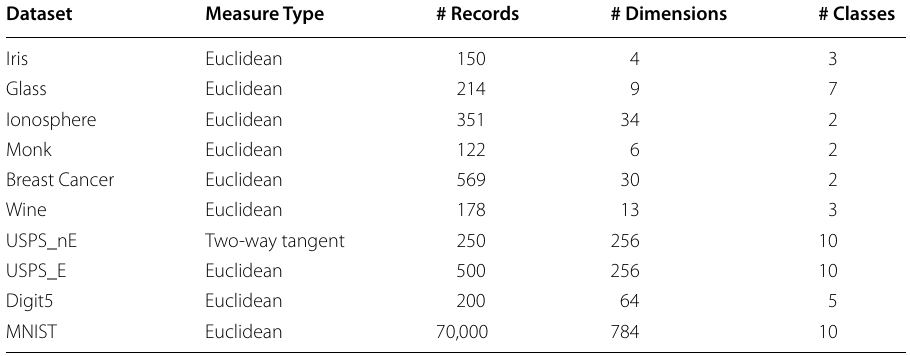
Table 1 Descriptions of the datasets